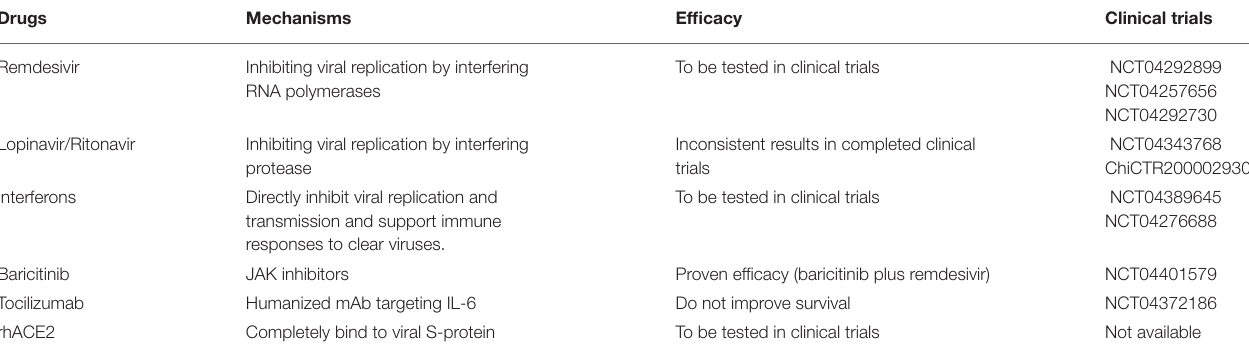
TABLE 4 | The efficacy and current status of COVID